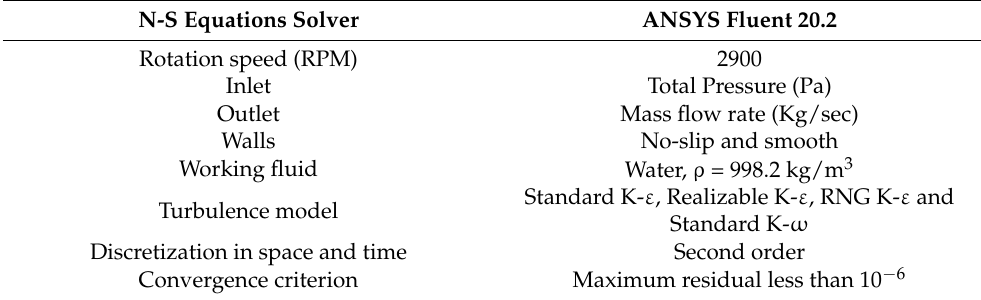
Table 1. Boundary conditions and simulation